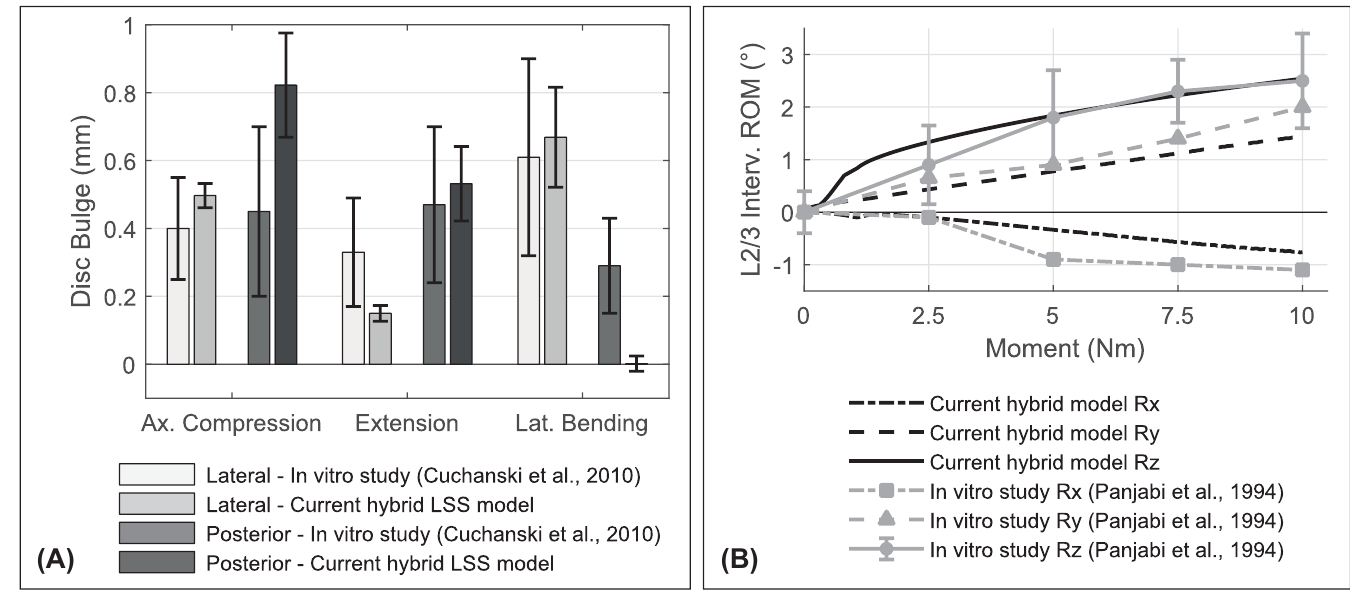
Fig 11. (A) Mean bulges of intervertebral discs and (B) load-displacement curves under pure axial rotation moment. (A) Comparison of L1/2 to L5/S1 disc bulges (mean ± standard deviation) with in vitro measurements of all lumbosacral levels [126]. Disc bulges are measured posteriorly and laterally. (B) Comparison of predicted coupled motion of hybrid FSU L2/3 with in vitro measurements